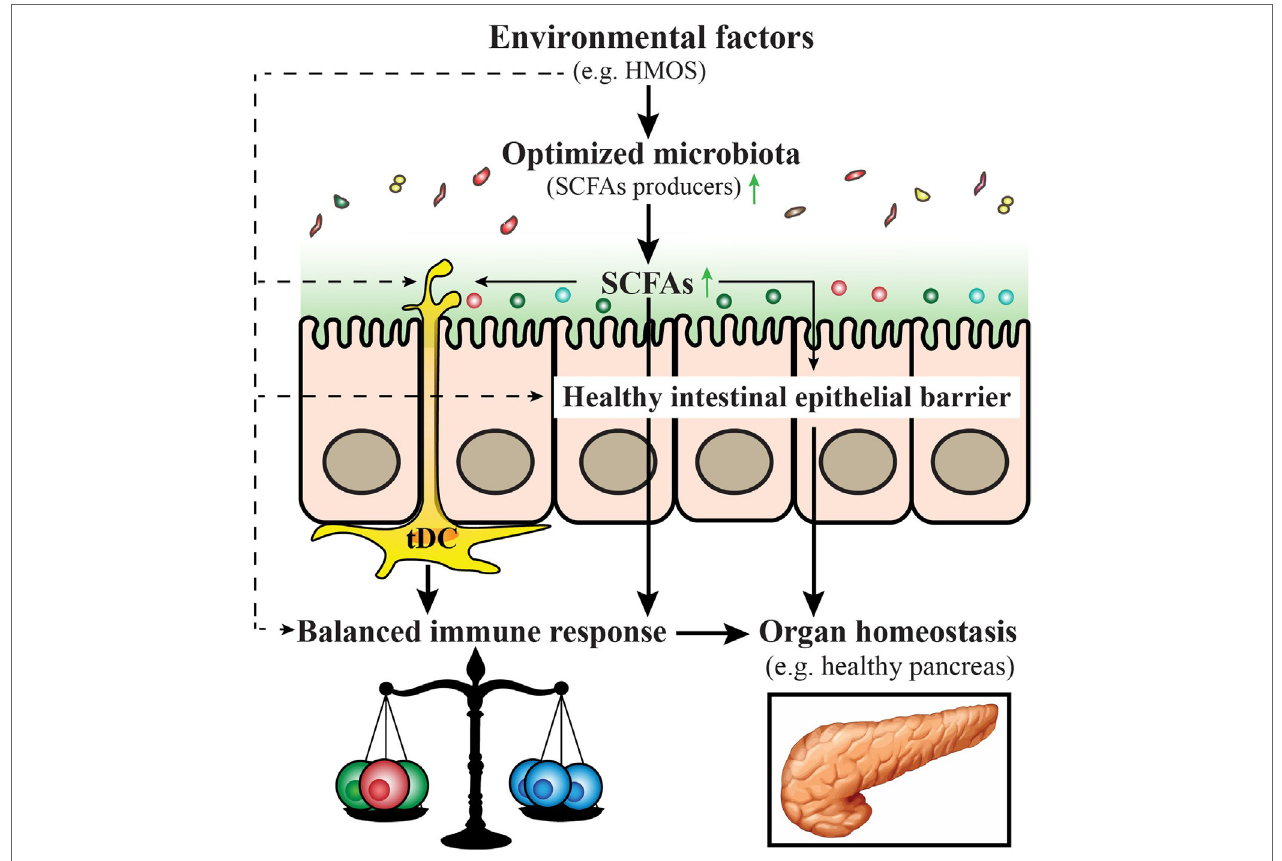
FiGURe 4 | Proposed model for prevention and/or treatment for type 1 diabetes (T1D) by early-life nutritional factors. Early-life nutritional factors such as human milk oligosaccharides (HMOS) can influence the development of T1D via direct effects (dash arrows) including induction of an optimized gut microbiota composition with increased short-chain fatty acids (SCFAs) producing bacteria, maintenance of gut integrity, induction of tolerogenic dendritic cells and subsequent balanced T-cell responses; and indirect effects (solid arrows), through effects on the composition of the microbiota, which produce metabolites such as SCFAs that have a favorable regulatory function on immune